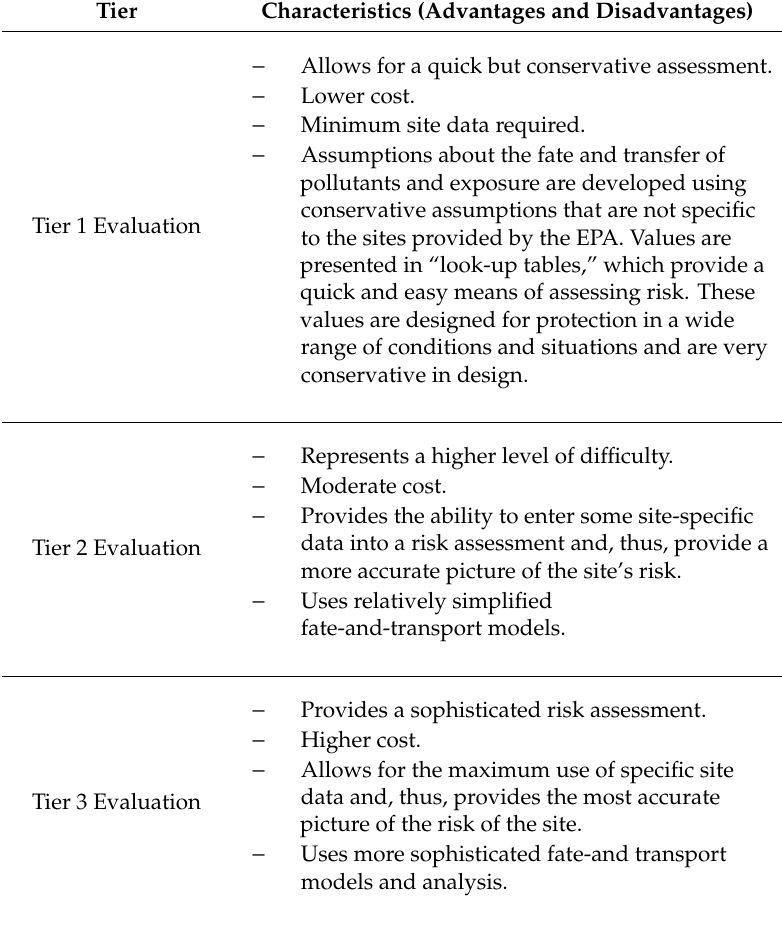
Table 1. Three-tiered approach for assessing the risk of waste treatment projects. Tier Characteristics (Advantages and Disadvantages) − Allows for a quick but conservative assessment. − Lower cost. − Minimum site data required. − Assumptions about the fate and transfer of Tier 1 Evaluation